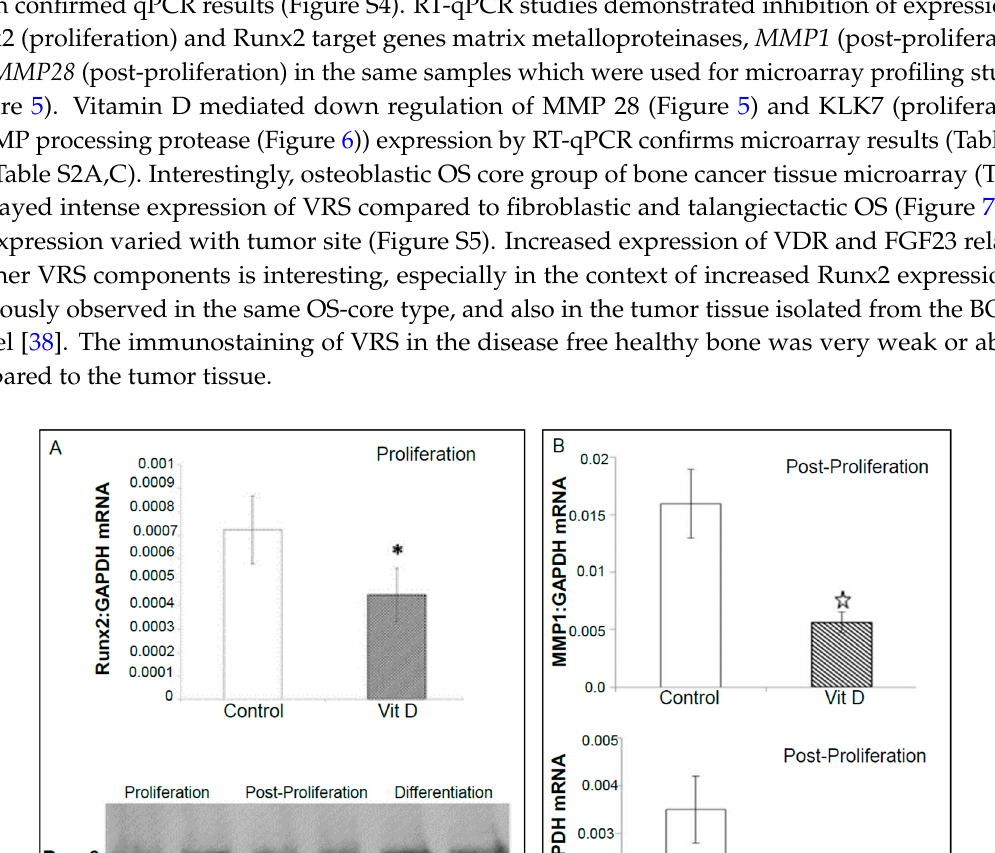
Figure 5. Effect of vitamin D in inhibiting the gene expression of: Runx2 ( A ); and Runx2 target genes MMP1 and MMP28 ( B ), in 143B osteosarcoma cells. Star indicates statistical significance of p ≤ 0.05.